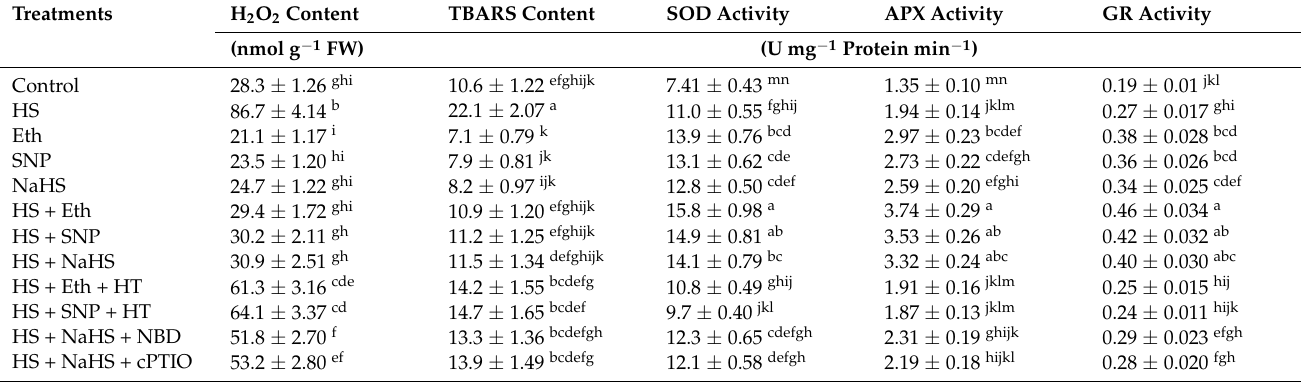
Table 4. Hydrogen peroxide (H 2 O 2 ), thiobarbituric acid reactive substances (TBARS) content, and activities of superoxide dismutase (SOD), ascorbate peroxidase (APX), and glutathione reductase (GR) in the leaves of rice ( Oryza sativa L.) cultivar Taipei-309 after foliar treatment of plants with 200 µ L L − 1 ethephon (Eth), 100 µ M sodium nitroprusside (SNP) or 200 µ M sodium hydrosulfide (NaHS) grown with or without high temperature stress (HS; 40 ◦ C) or 100 µ M hypotaurine (HT), 100 µ M 2-4- carboxyphenyl-4,4,5,5-tetramethylimidazoline-1-oxyl-3-oxide (cPTIO) or 100 µ M norbornadiene (NBD) scavengers of hydrogen sulfide (H 2 S), nitric oxide (NO), and ethylene action inhibitors, respectively, with HS at 15 days after sowing. Data are presented as treatments mean ± SE ( n = 4). The values followed by the same letters did not differ significantly by LSD test at p < 0.05. FW, fresh weight.